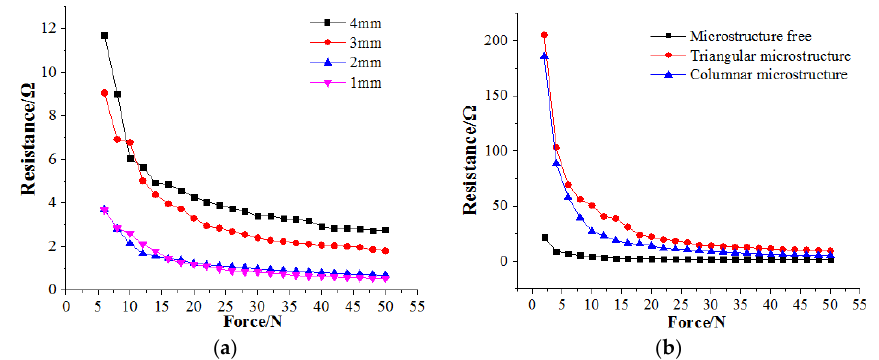
Figure 2. Piezo-resistive properties of different thickness and microstructure arrays. ( a ) Piezo-resistive properties of different thicknesses. ( b ) Piezo-resistive properties of different